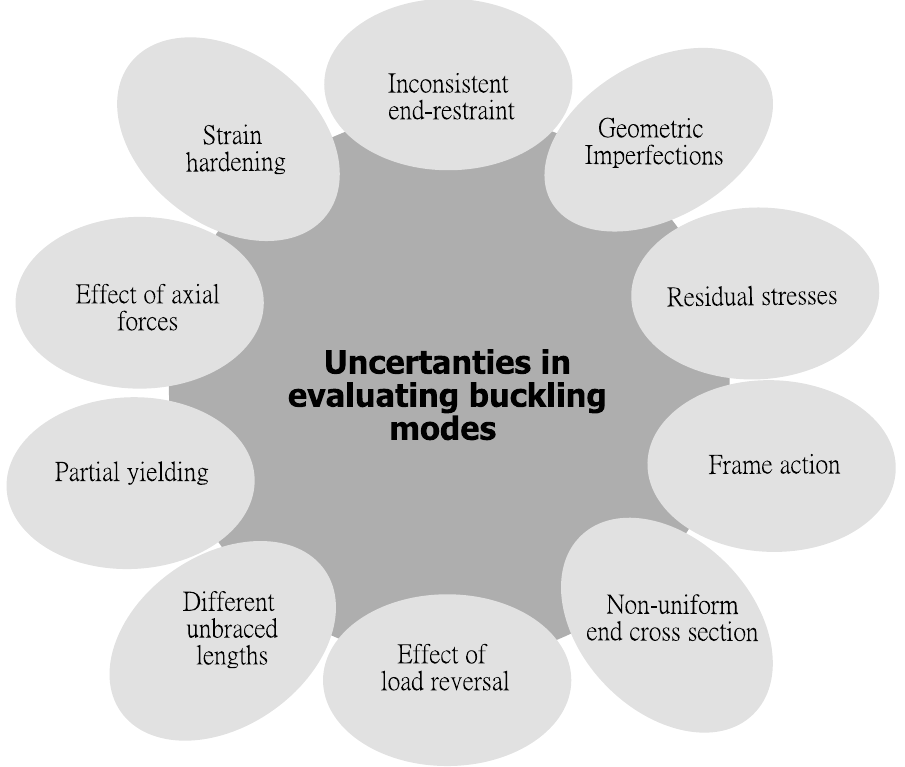
Figure 7. List of uncertainties involved in predicting buckling directions.